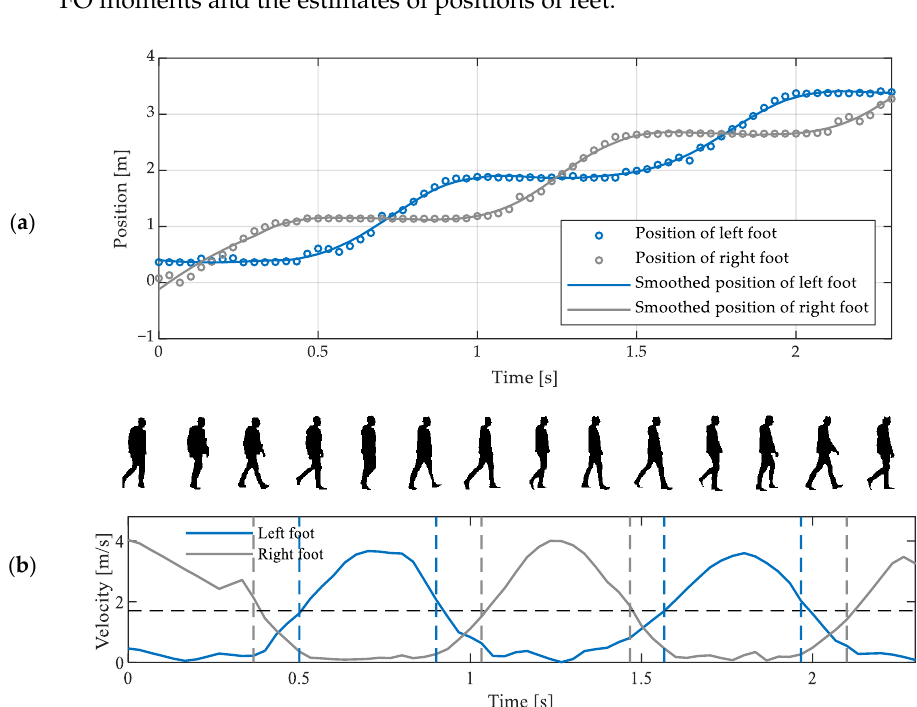
Figure 5. ( a ) Exemplary estimates of anteroposterior positions of a walking person’s feet, obtained using a depth sensor, and the results of their smoothing using a Savitzky-Golay filter; ( b ) Exemplary dependences of the horizontal velocity of a walking person’s feet on time, with the empirically selected threshold value indicated by the horizontal dashed line, the detected FO and FC moments indicated by the vertical dashed lines, and the silhouettes of that person extracted from the corresponding depth images.